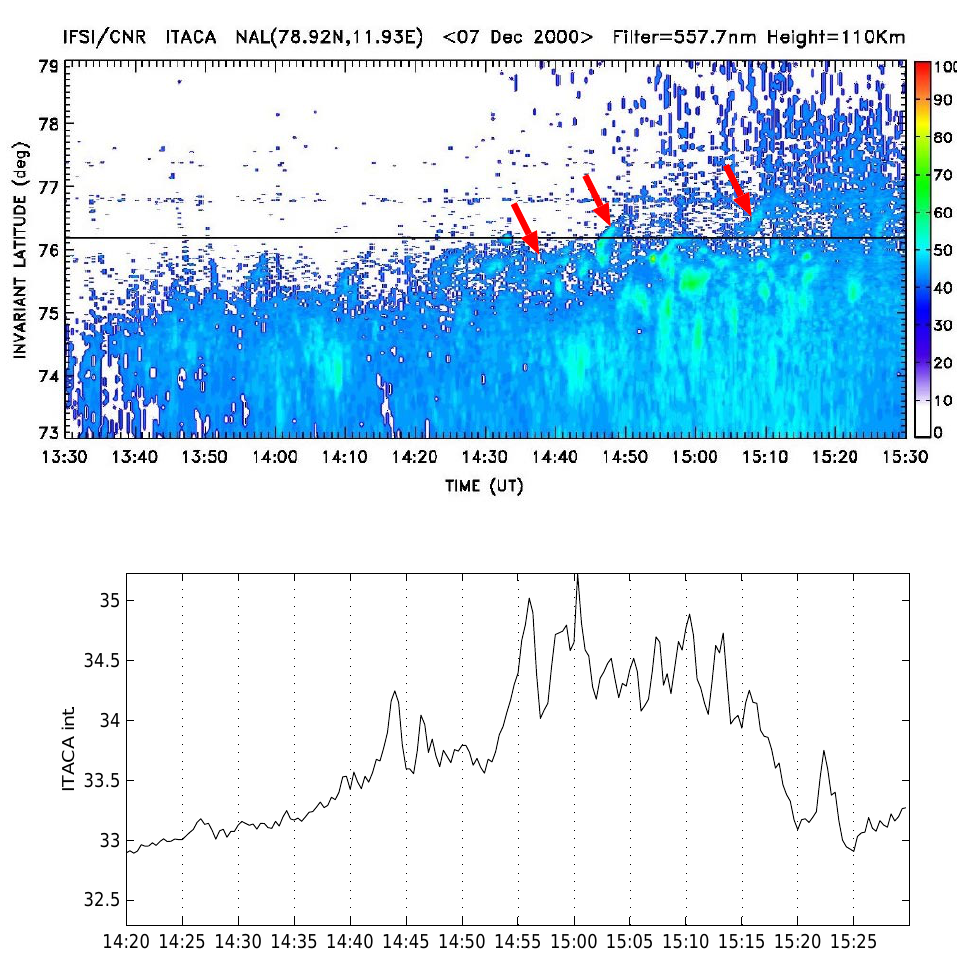
Fig. 4. (Top panel) The ITACA keogram and (bottom panel) temporal variations of the average auroral intensity (in ADUs) along the middle magnetic meridian of the camera